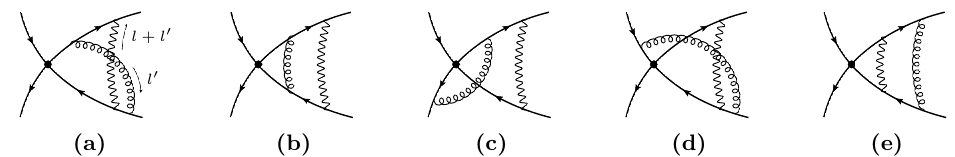
Figure 2 . Two-loop diagrams generating the double-logarithmic power-suppressed corrections. The loopy line corresponds to the leading-power Glauber gauge boson with the momentum l 0 . The symmetric diagrams are not